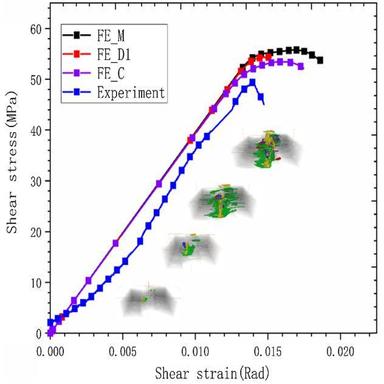
The overall failure process.